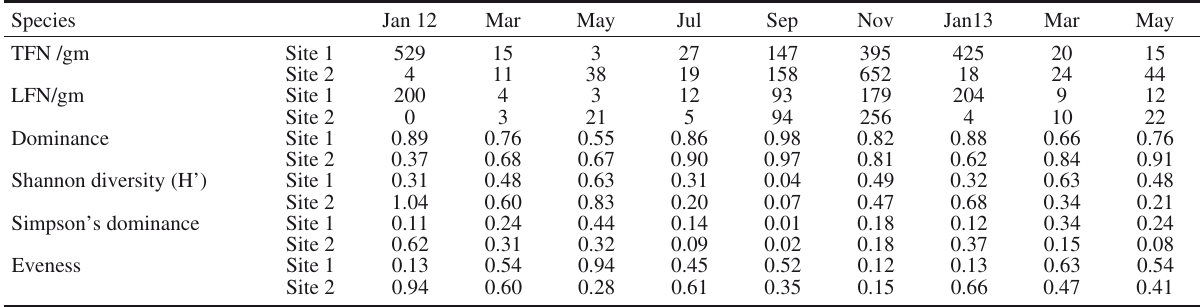
Table 1. – Diversity characteristics of the total foraminiferal population at Site 1, Payyannur (PNR) and Site 2, Panambur (PNBR) . Species Jan 12 TFN